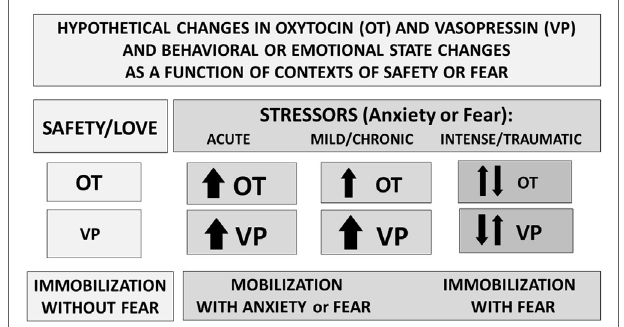
FiGURe 3 | Perceived context and the intensity of challenge can regulate the release or effects of oxytocin (OT) and vasopressin (VP). Under conditions of safety, the actions of OT may dominate, supporting high levels of sociality. In response to an acute stressor, both OT and VP increase, supporting mobilization and escape, followed in some cases by increases in social behavior especially toward “safe” conspecifics. Following intense or traumatic stressors, initial responses would include mobilization and anxiety. However, following a traumatic experience, individuals may vacillate between mobilization and immobilization with fear or revert to the more primitive response of shutting down. These patterns differ between males and females and as a function of individual life